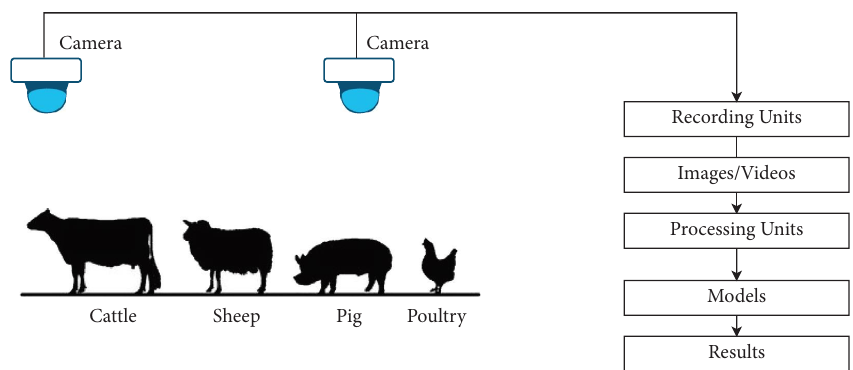
Figure 3: Computer vision in livestock farming source